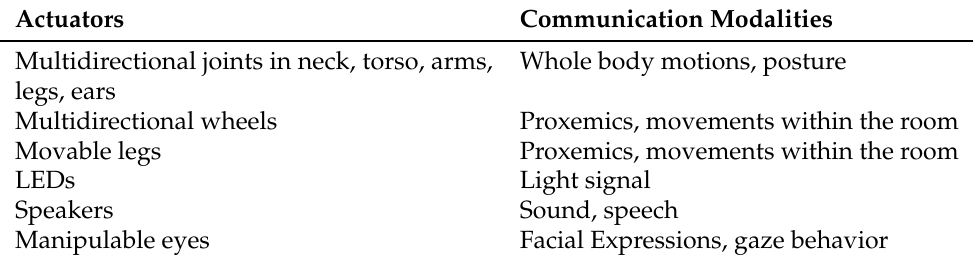
Table 1. Overview of the actuators social robots typically feature and related modalities they can use to communicate with the